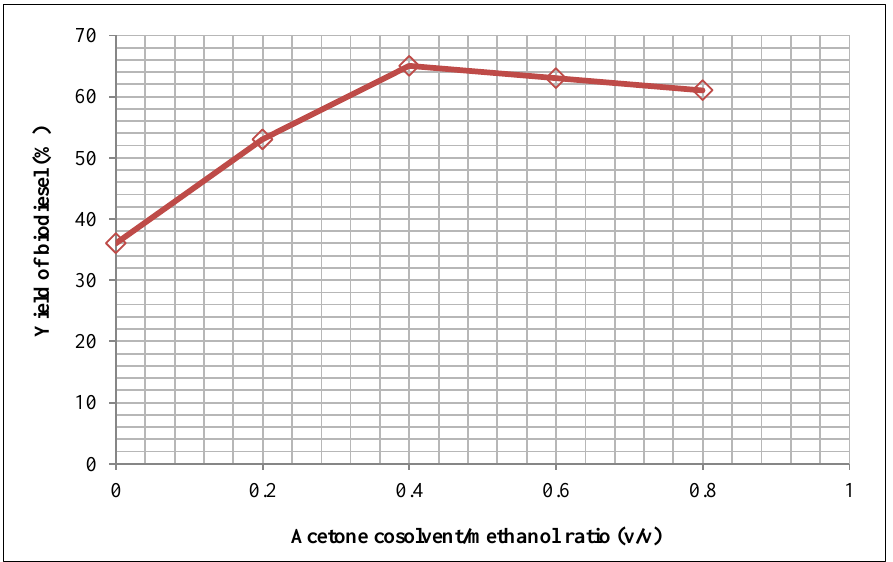
Figure 6. Effect of acetone co-solvent/methanol ratio (v/v) on biodiesel